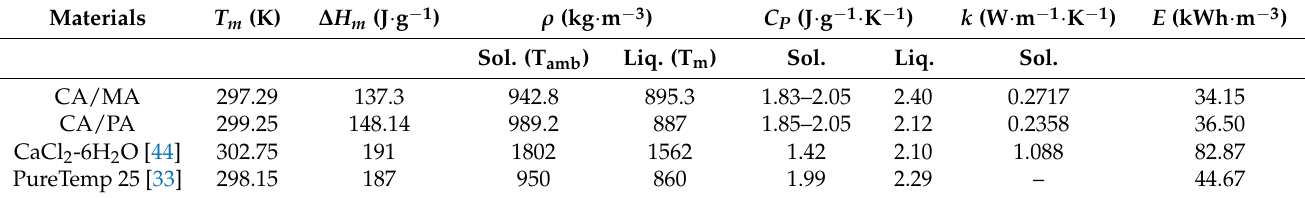
Table 13. Comparison of PCM in the temperature range of